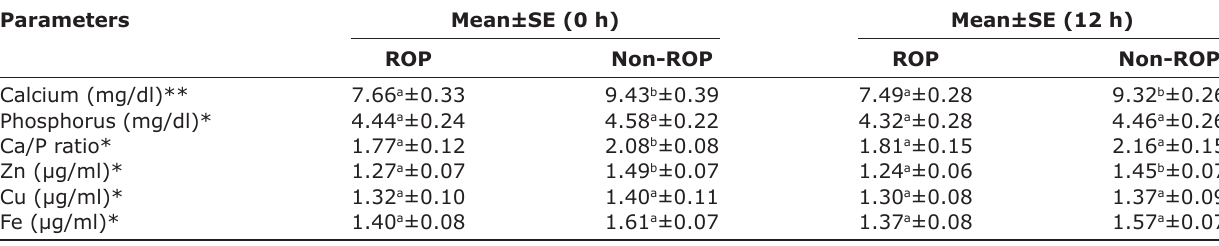
Table-1: Macro and Micro-minerals profiles in ROP and non-ROP crossbred cattle.